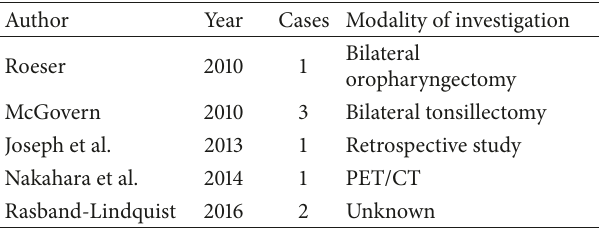
Table 1: Previously reported cases of bilateral synchronous HPV- related tonsillar carcinoma since